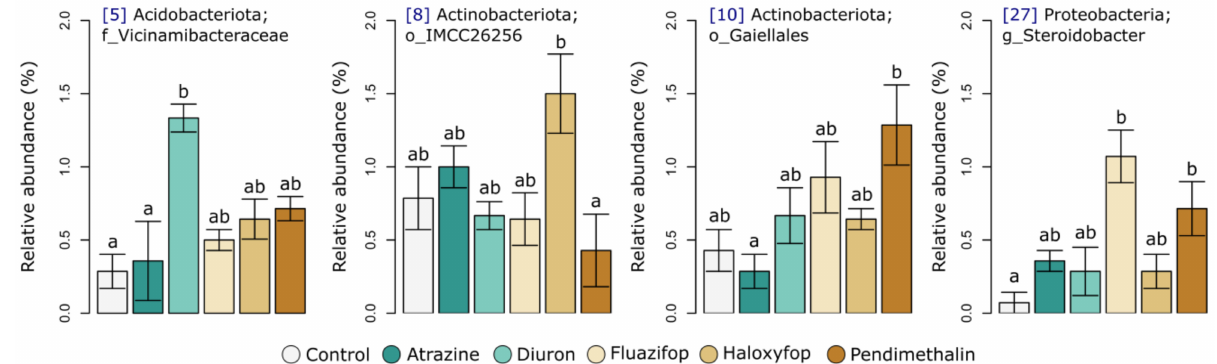
Figure 5. Bar plots representing the mean relative abundances of OTUs that were identified as significant indicators of herbicides on day 30. The blue numbers in square brackets are OTU IDs and are consistent with the heatmap. Error bars represent standard errors of the means, and the letters above the bars indicate significant differences ( p < 0.05) between treatments according to ANOVA with post hoc Tukey